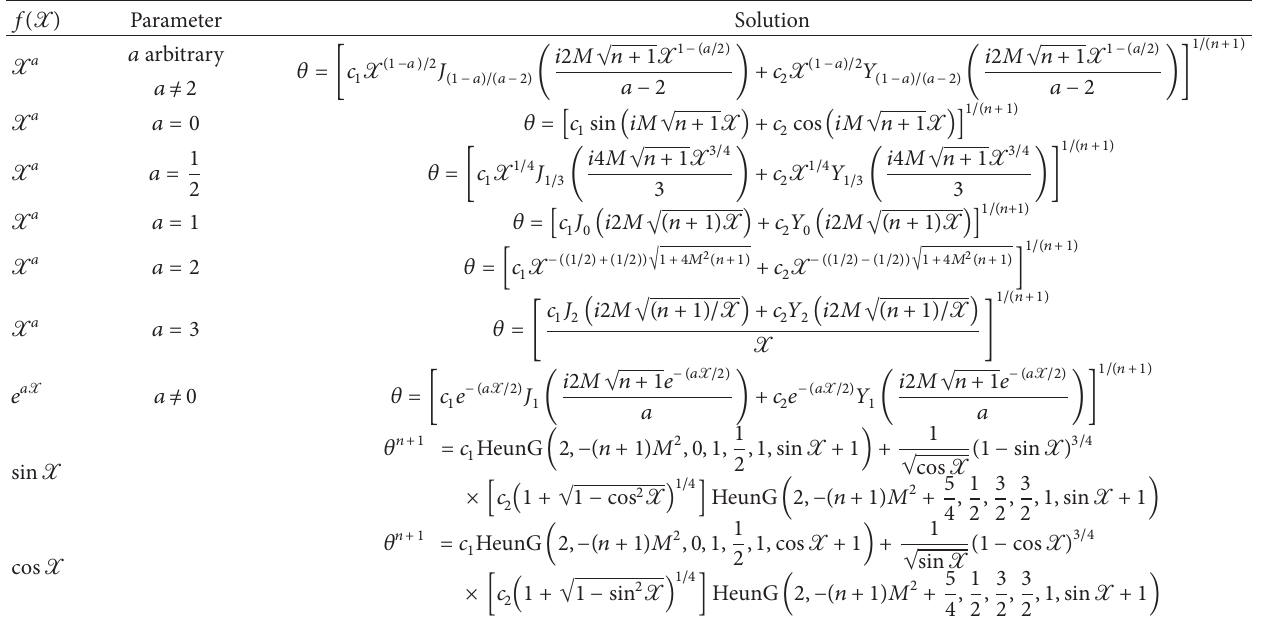
Table 2: Modified general solution for 𝑓( X ) where X = 𝑥 + 1 , 𝑛 > −1 , and 𝑚 = 𝑛 ̸= − 1